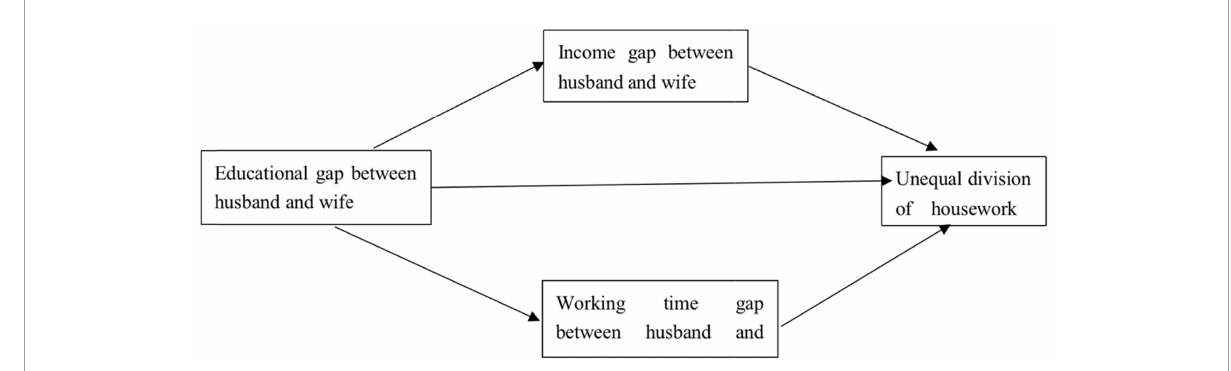
FIGURE1 Research conceptual